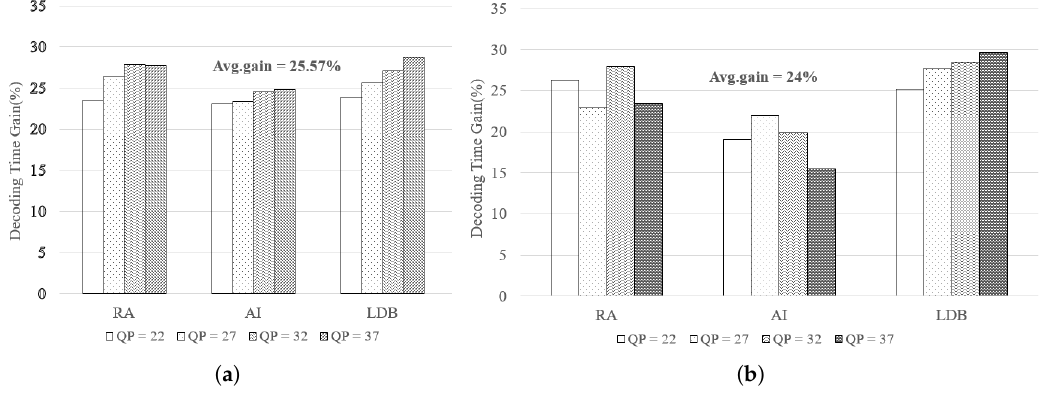
Figure 15. Decoding Time Gain (%) following test sequences ( a ) PeopleOnStreet , ( b ) Traffic